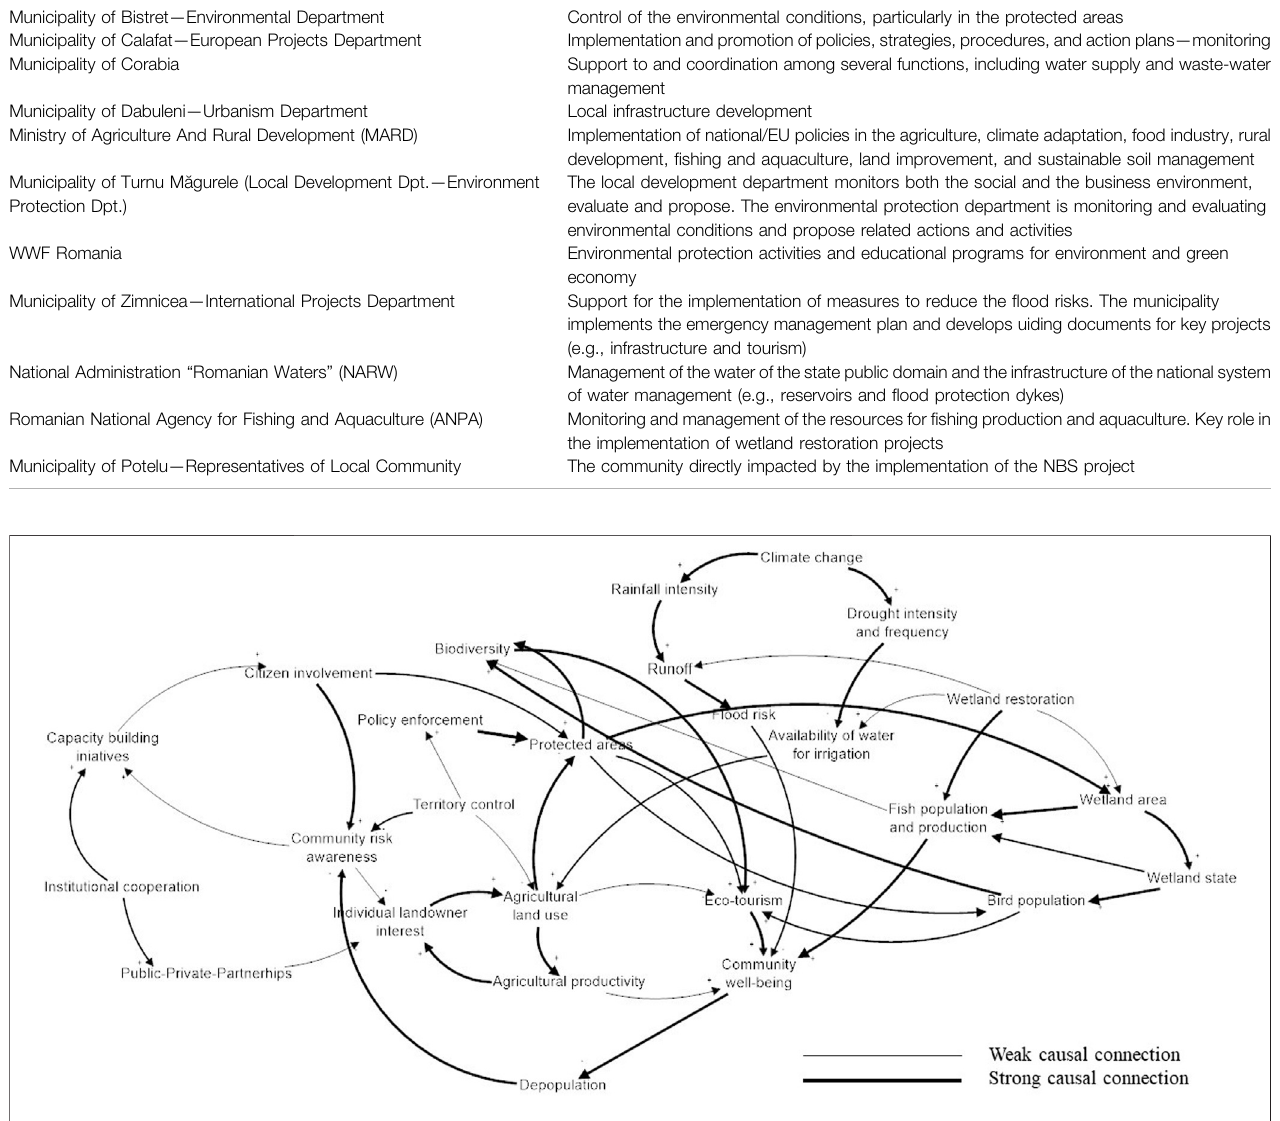
FIGURE 4 | Aggregated FCM for the Potelu